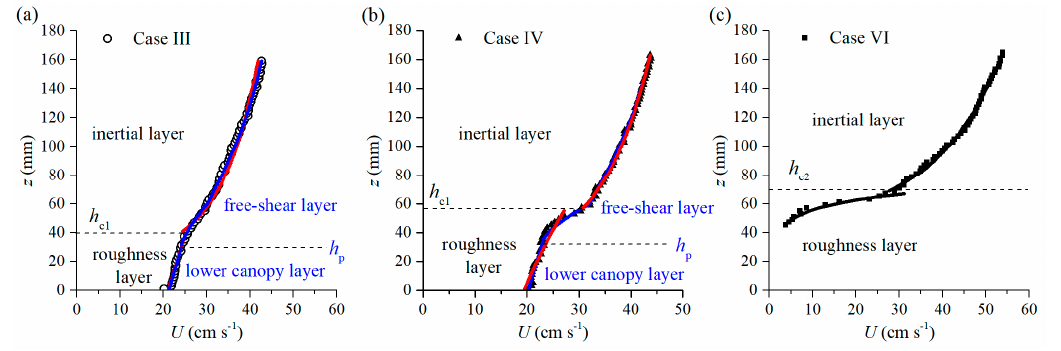
Figure 11. U Profiles along the depth for ( a ) Cases III, ( b ) Case IV and ( c ) Case VI.